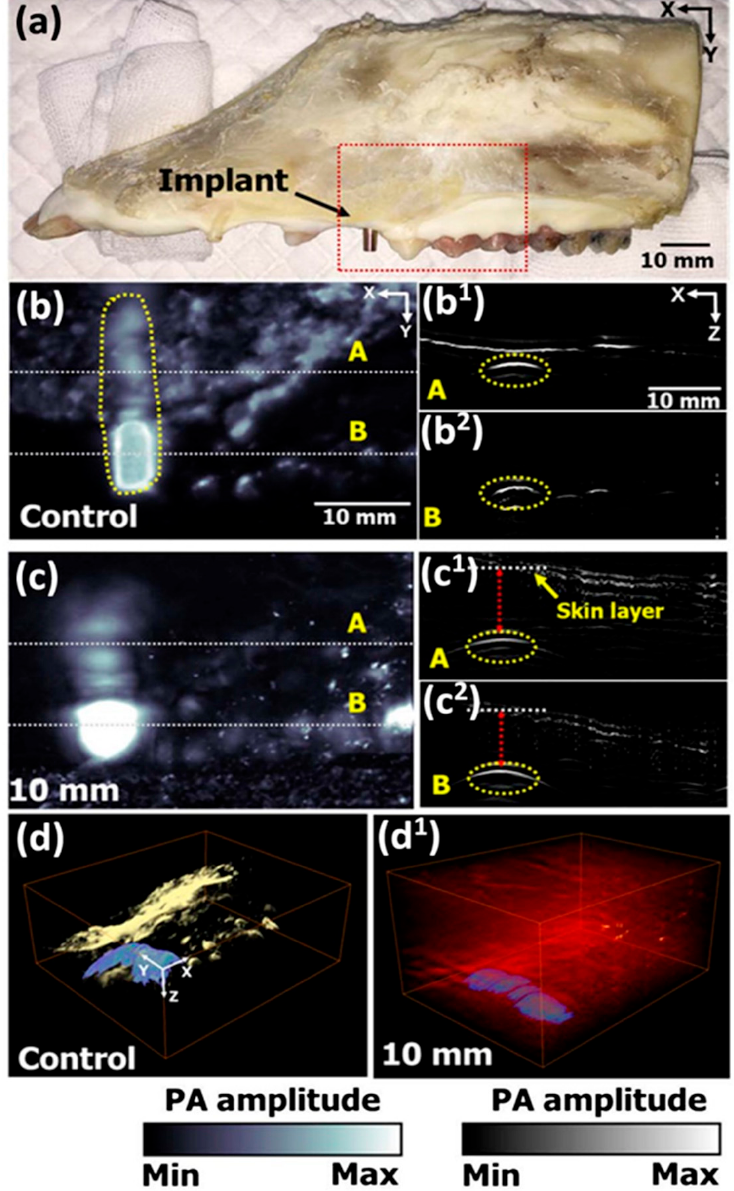
Figure 7. Ex vivo PA image of porcine jawbone with titanium implant abutment (EZ Post, MIEP3525HT, Megagen, Korea) and a fixture (MIIF3008C, Megagen, Korea). ( a ) Jawbone specimen. ( b ) PA image at 1064 nm excitation. ( c ) PA MAP images from ( b ) under 10 mm of chicken tissue. ( d ) 3D render of bare bone specimen ( d ) and under 10 mm chicken tissue ( d 1 ). ( b 1 , b 2 ) and ( c 1 , c 2 ) are cross-sectional PA images of the dashed line areas in corresponding ( b , c ) images.Reprinted with permission form Lee et al. (2017) [59] Copyright The Optical Society of America, 2017.